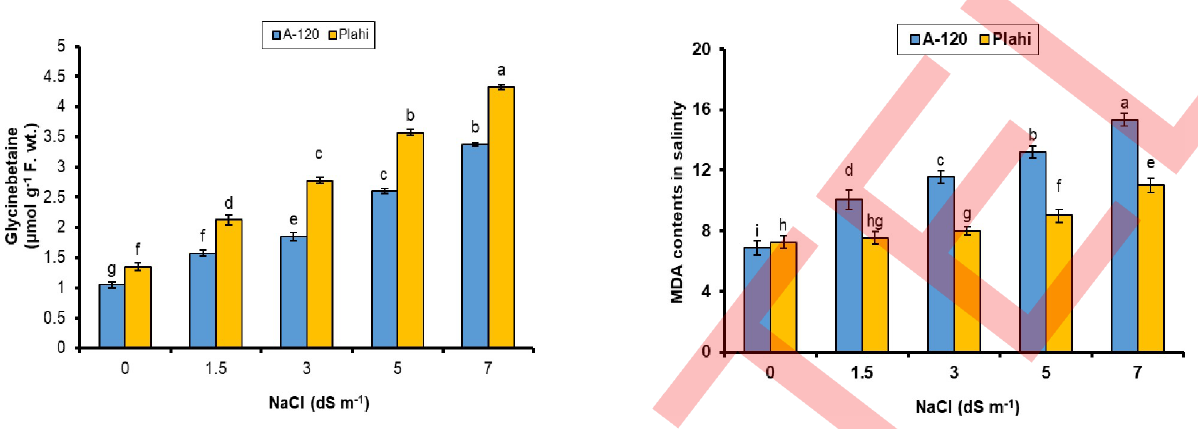
Fig 3. Effect of NaCl stress on glycine betaine and MDA content of two chili genotypes.